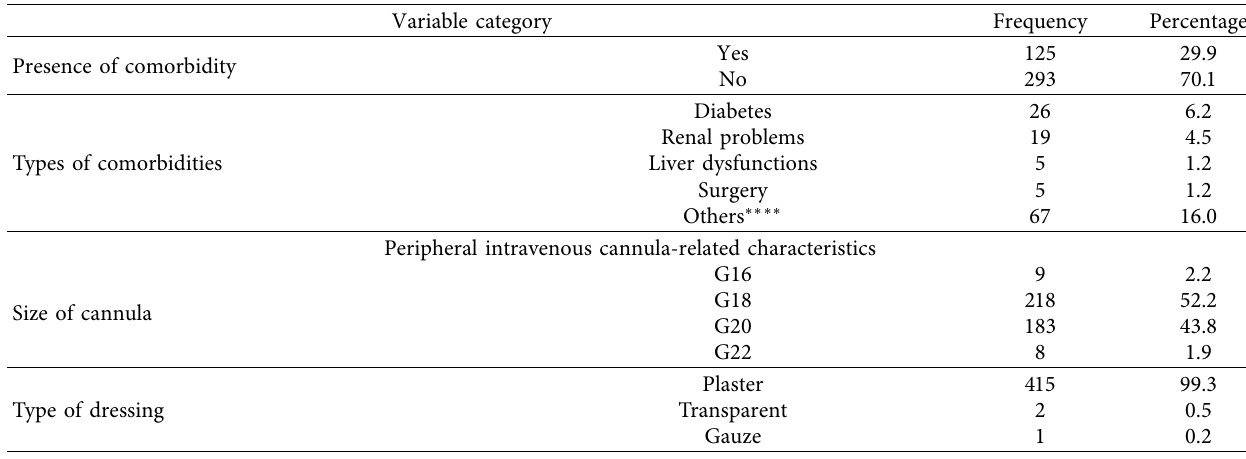
Table 2: Peripheral intravenous cannula-related features to assess the incidence and associated factors of failed first intravenous